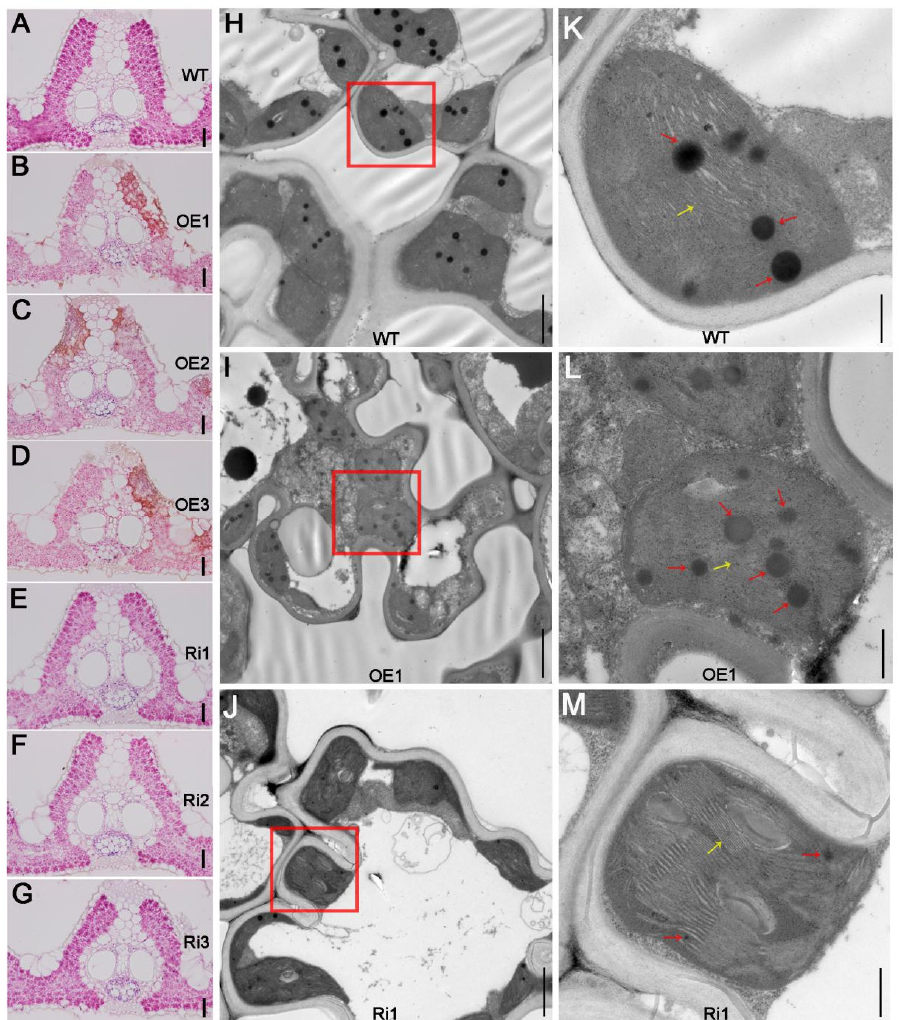
Figure 3. Leaf senescence regulated by OsAAP3 is related to chloroplast degradation and cell death. Paraffin sections were used to detect the chloroplasts in the wild-type (WT) ( A ), overexpressing (OE) lines ( B – D ), and RNA interference (Ri) lines ( E – G ). Transmission electron sections were used to detect the chloroplasts in the WT ( H , K ), OE lines ( I , L ), and Ri lines ( J , M ). Paraffin sections ( A – G ) were stained with hematoxylin for 5 min and eosin for 2 min.The red frames in ( H – J ) indicate chloroplasts, the yellow arrows in ( K – M ) indicate thylakoids, and the red arrows in ( K – M ) indicate plastoglobules. The flag leaves was taken at 110 days after sowing. Scale bar = 30.0 mm in ( A – G ), 2.0 µ m in ( H – J ), and 0.5 µ m in ( K – M